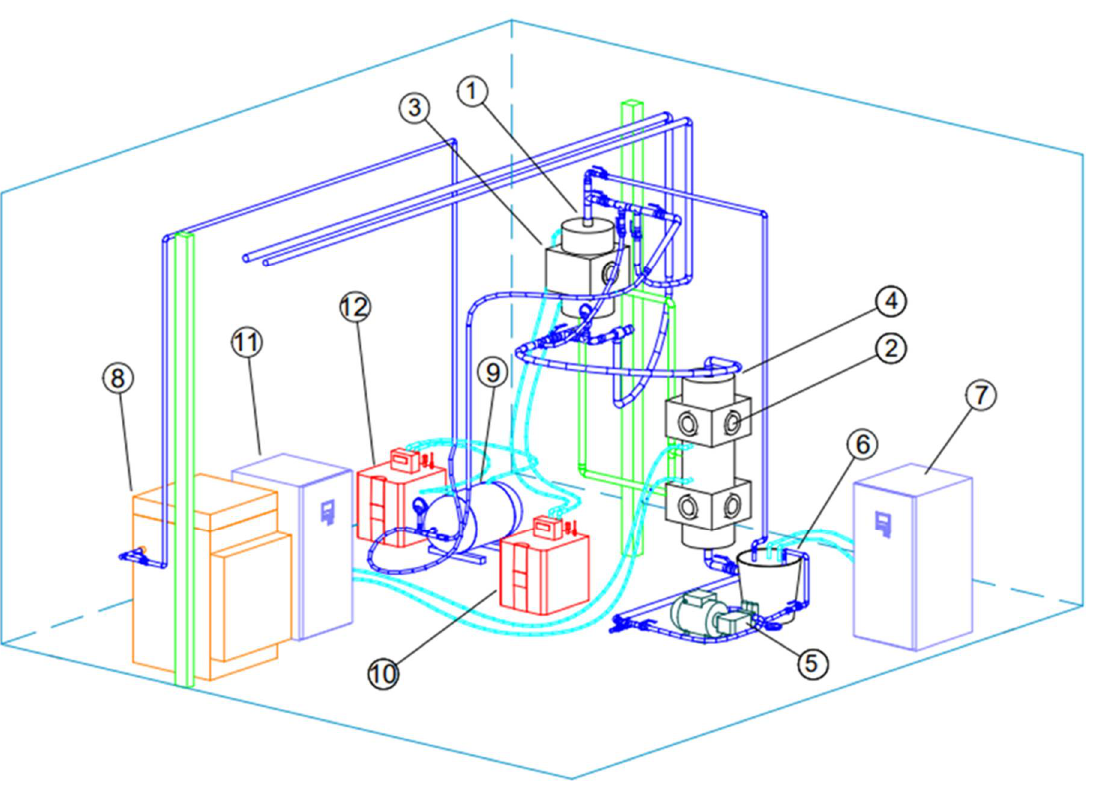
Figure 2. Visualization of the experimental device in 3D. The refence lines are described in Table 1.